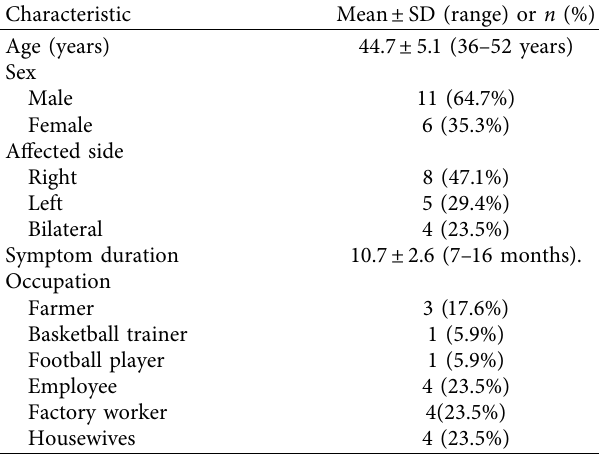
Table 1: Demographic characteristics of the patients.